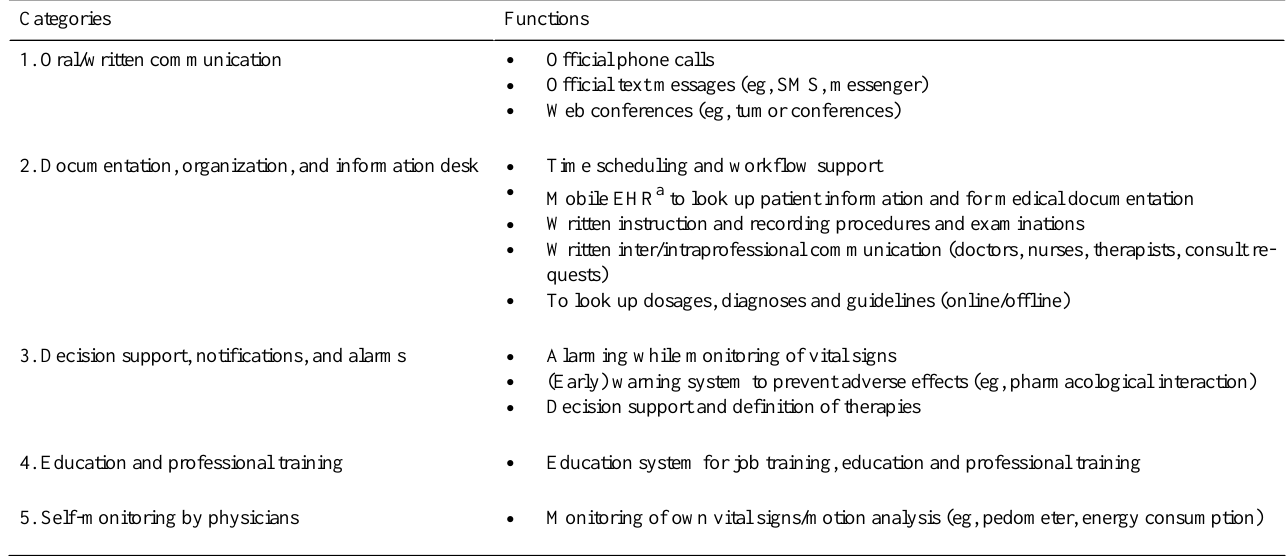
Table 1. Fields of application of mobile devices in stationary hospital